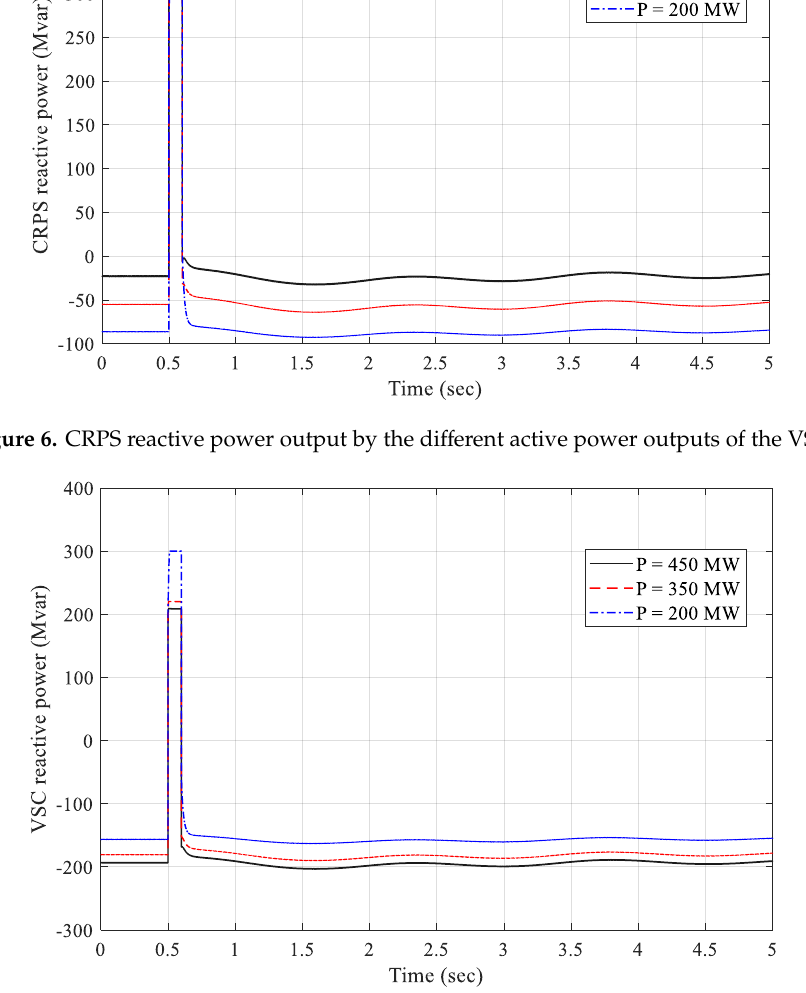
Figure 7. VSC reactive power output by the different active power outputs of the VSC.